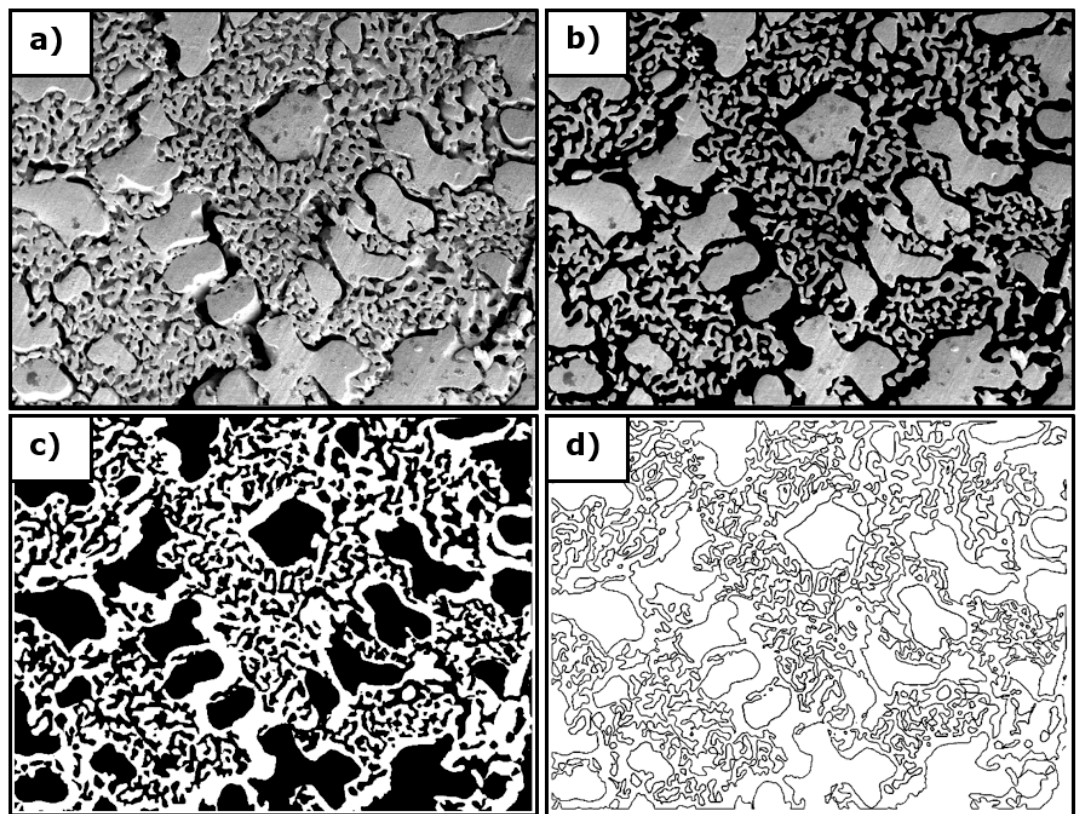
Figure 9. Example of steps for percent porosity estimation of one sample. ( a ) original SEM photograph; ( b ) removal of areas that do not correspond to the observed cutting plane; ( c ) conversion of the RGB image to binary image and black and white inversion, so that the white areas correspond to pores; and ( d ) boundaries of pores observed in the photograph.